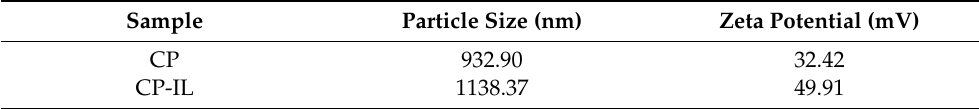
Table 1. The particle size and Zeta potential of CP, and CP-IL.